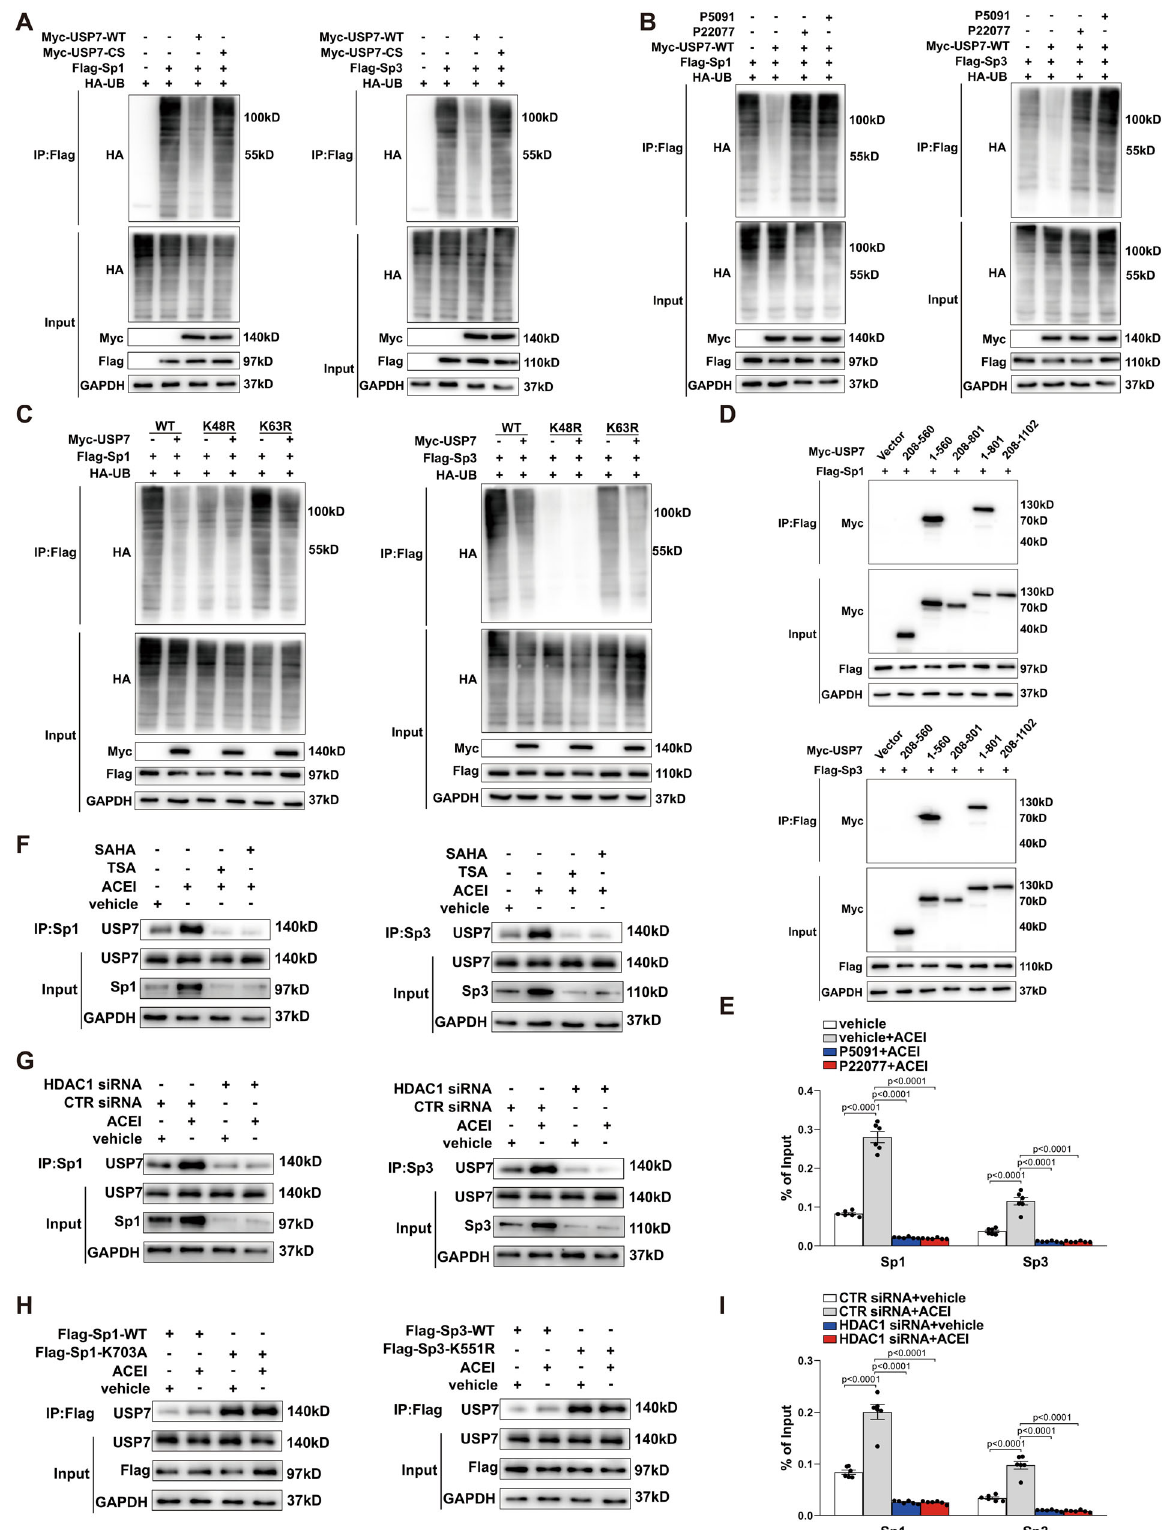
Sp3 mutant(Flag-Sp3-K551R)inwhichtheacetylationsitesLys-703 and Lys-551 were mutated to alanine and arginine, respectively.